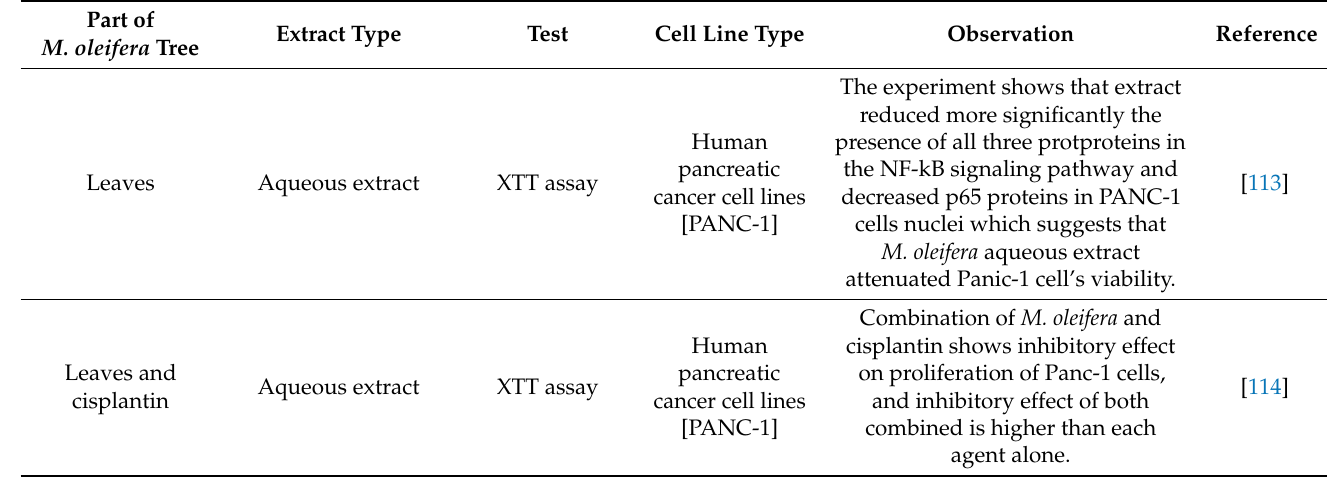
Table 5. Anticancerous activity of M. oleifera plant extract on different cancer cell